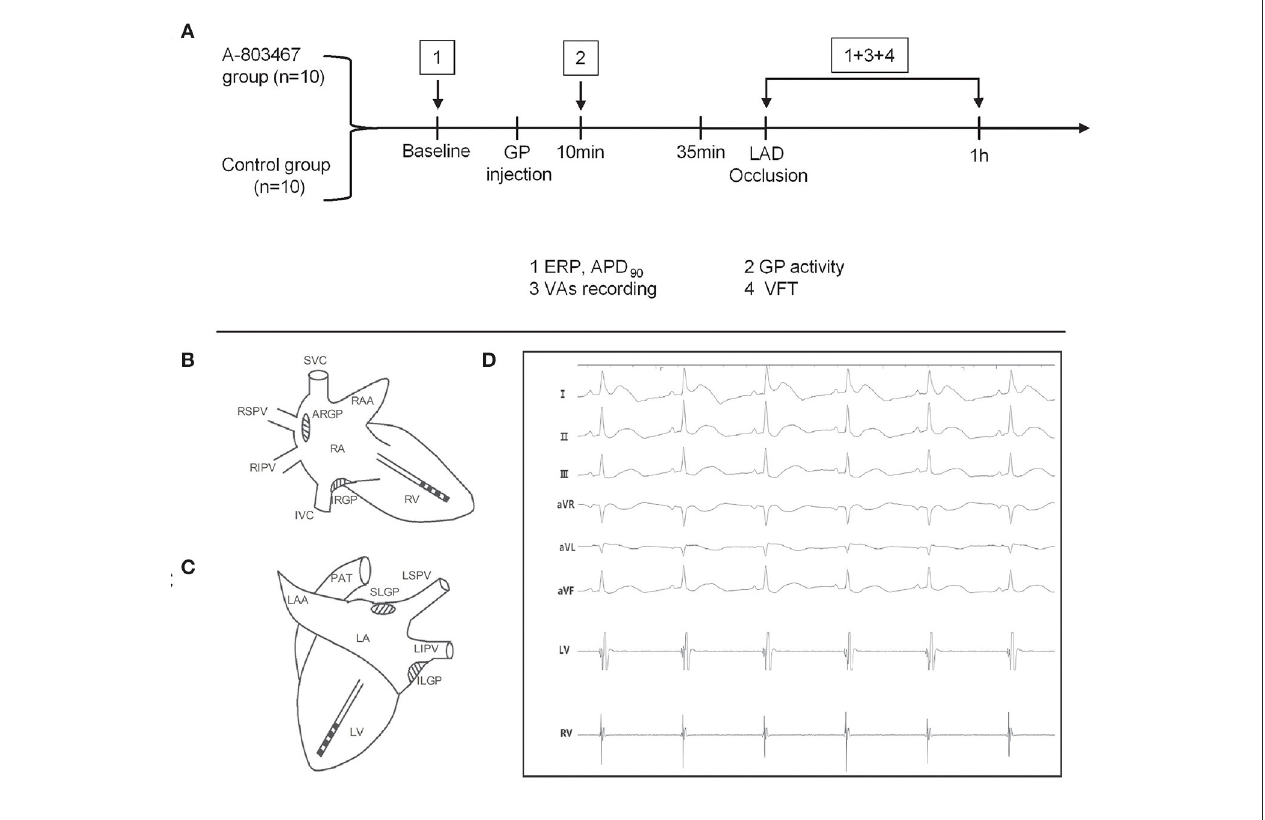
FIGURE 1 | Schematic representation of the study protocol (A) and catheter positions in the right (B) and left (C) ventricular free walls. (D) Surface electrocardiograms and local cardiac electrograms recording after left anterior descending coronary artery occlusion.